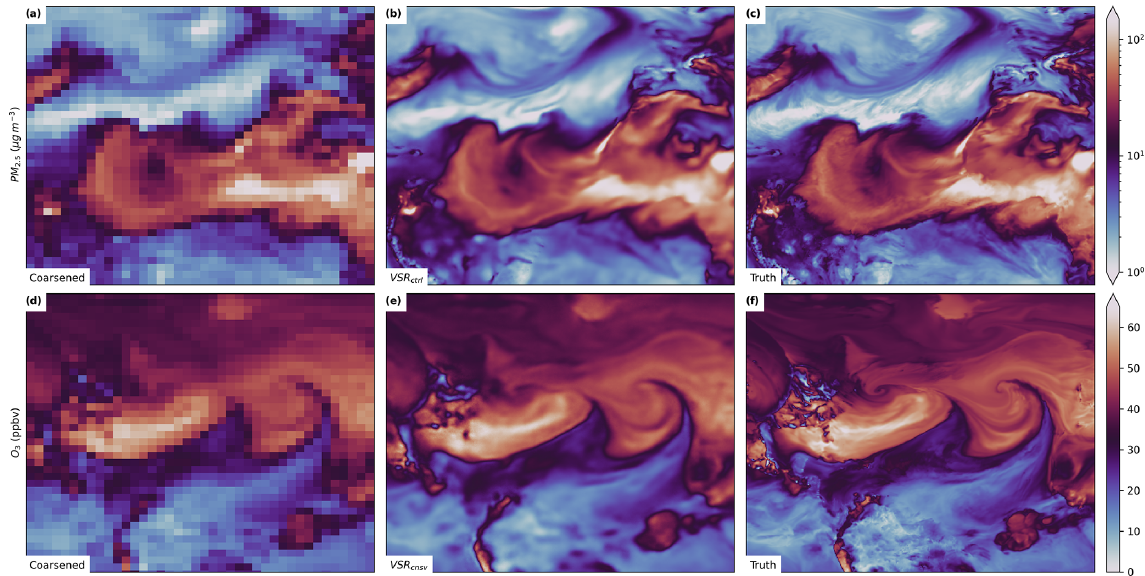
Figure 3. Sample cases for PM 2 . 5 and O 3 . Same as Fig.